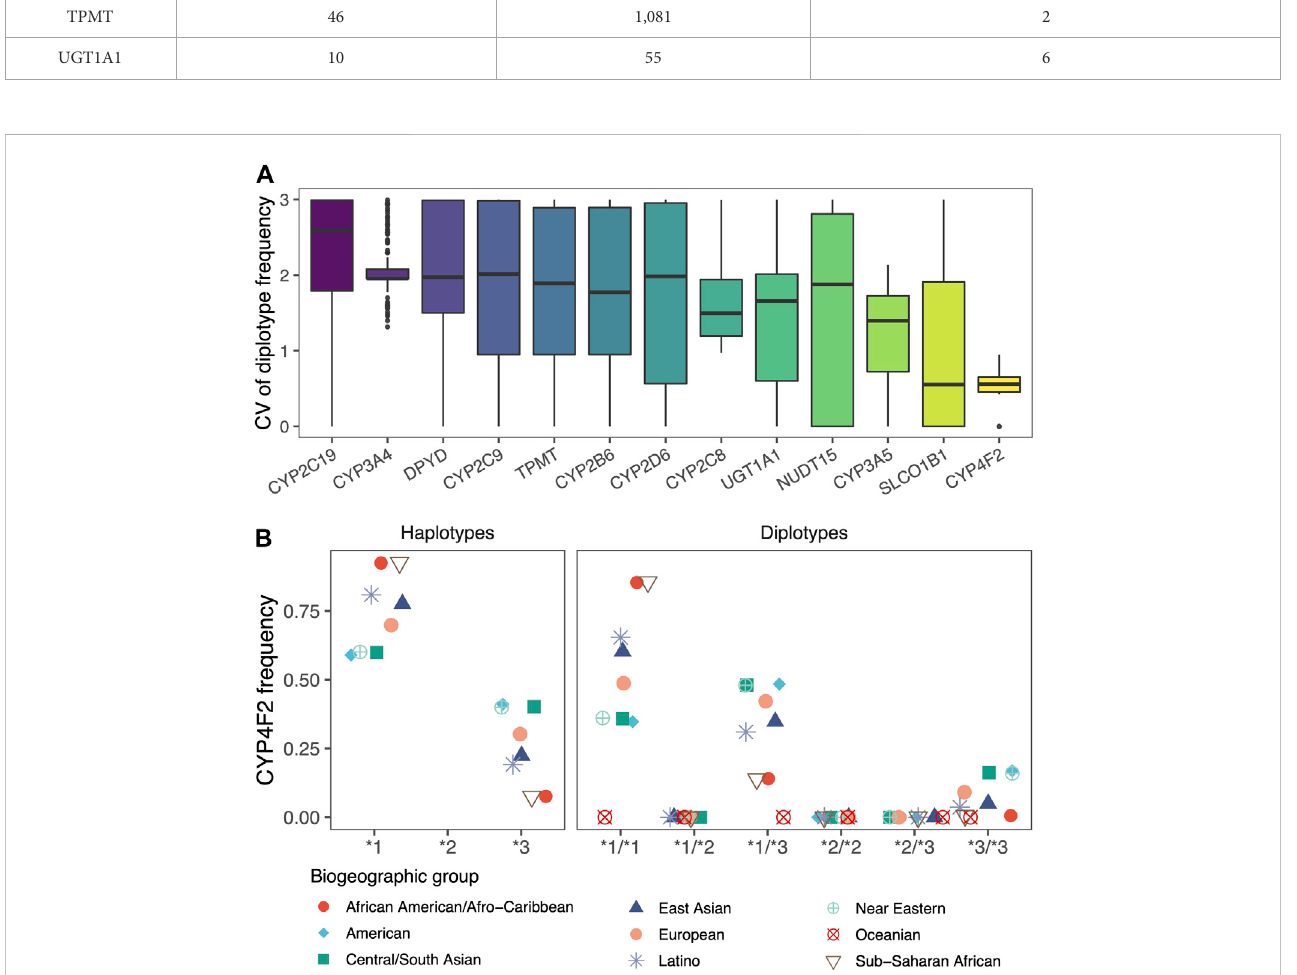
FIGURE 4 Differencesindiplotypefrequenciesacrosspopulations. (A) Boxplotsshowedthedifferencesinthefrequenciesofdiplotypesin13genesacrossthenine biogeographic groups, which are characterized by coef fi cients of variation (CV). (B) Scatter plot showed the haplotype frequencies of CYP4F2 and the diplotype frequencies calculated according to Hardy-Weinberg equilibrium. Jittering was applied to avoid